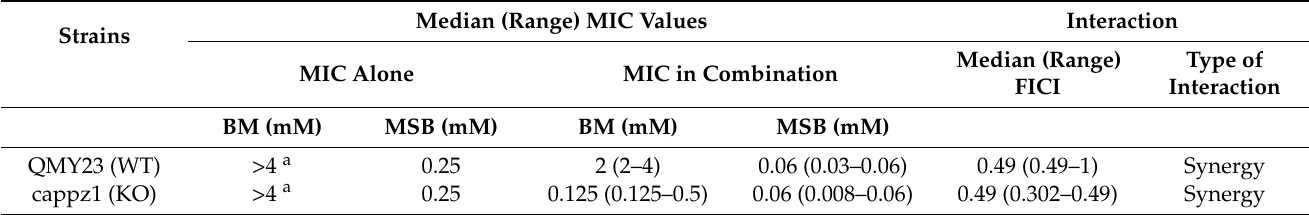
Median (Range) Type of FICI Interaction